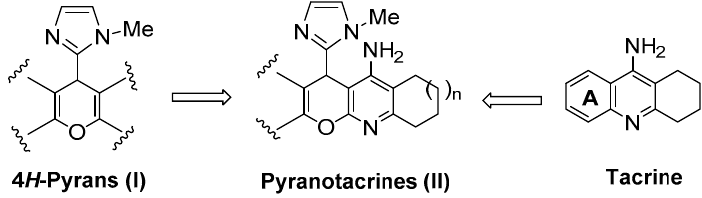
Figure 1. General structure of tacrine, 4 H -pyrans ( I ), and the new racemic imidazopyranotacrines ( II ).